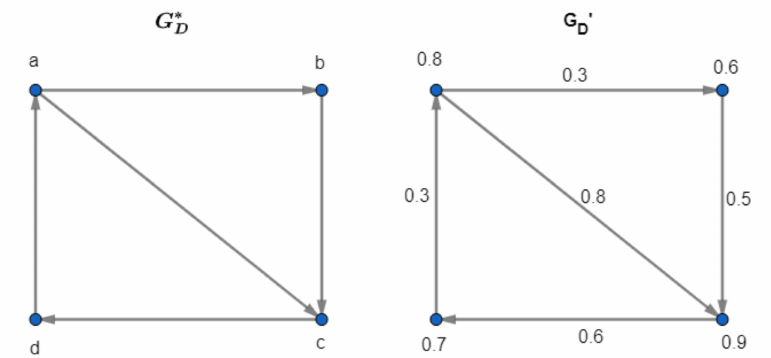
Figure 4. G (cid:48)